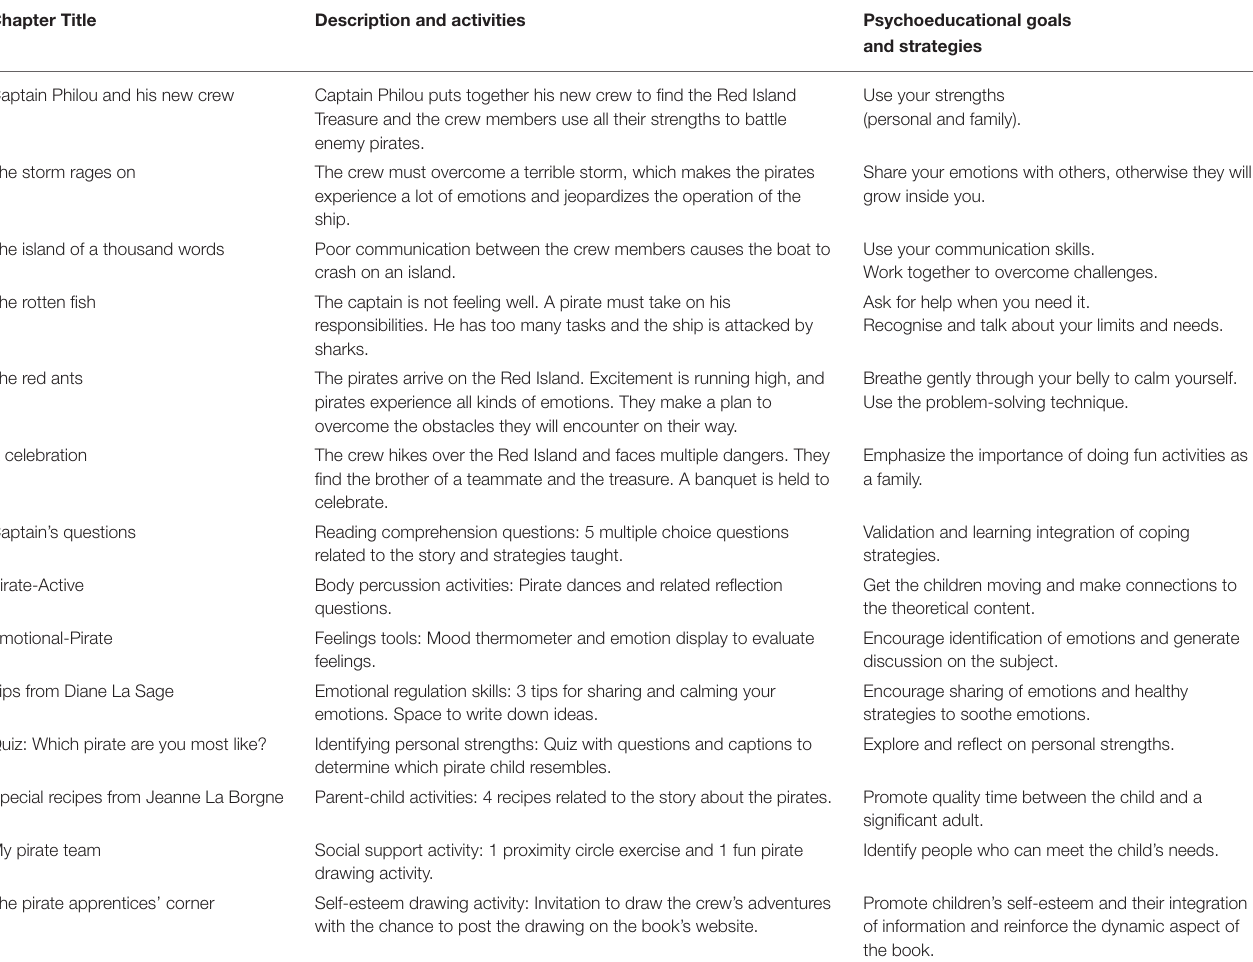
TABLE 1 | Strategies and activities of the book. Description and activities Psychoeducational goals